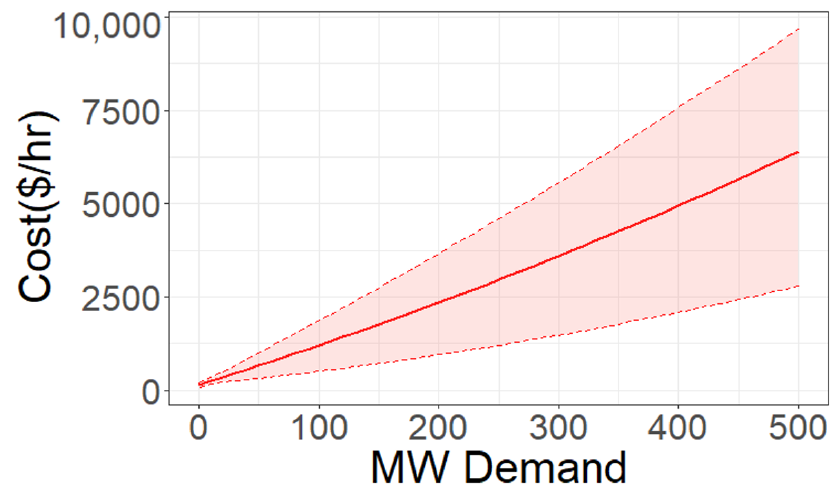
Energies 2022 , 15 , x FOR PEER REVIEW